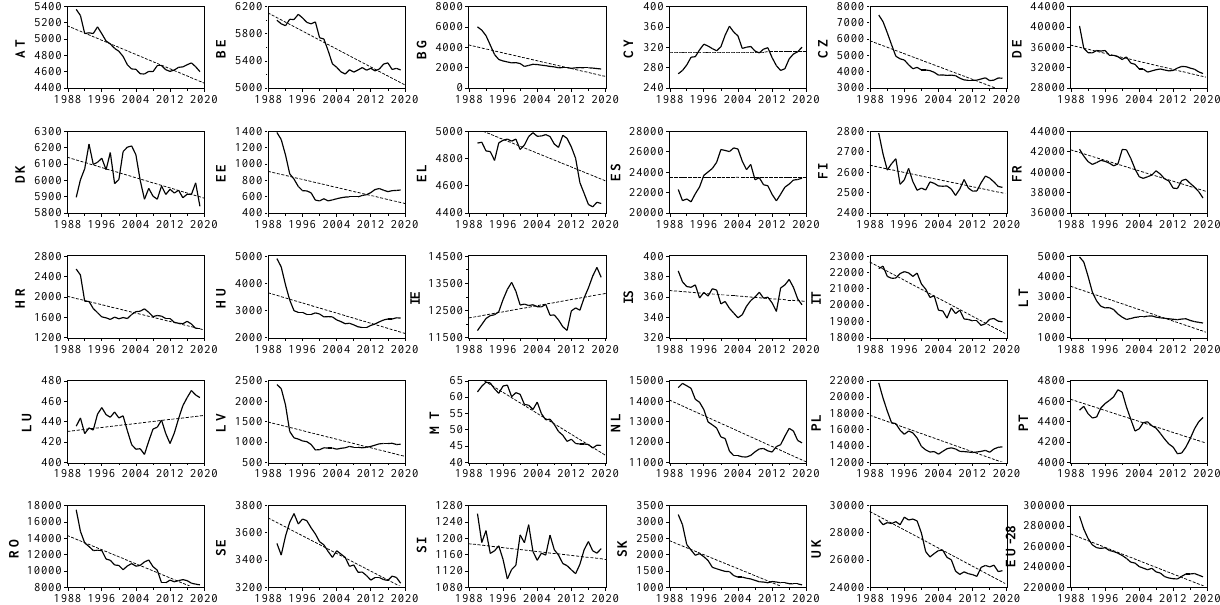
Figure 4. Time evolution of N 2 O emissions between 1990 and 2019 within EU-28 (agricultural sector).